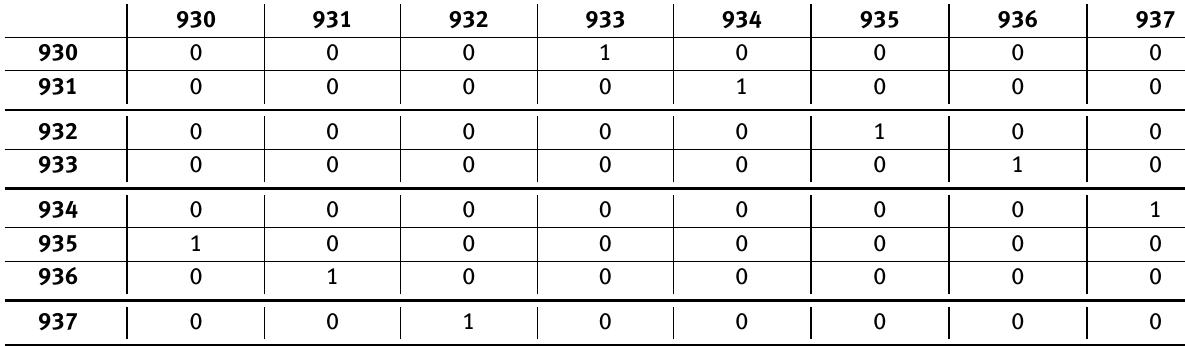
Table 4: Solution of assignments on the route Kosice – Zvolen.